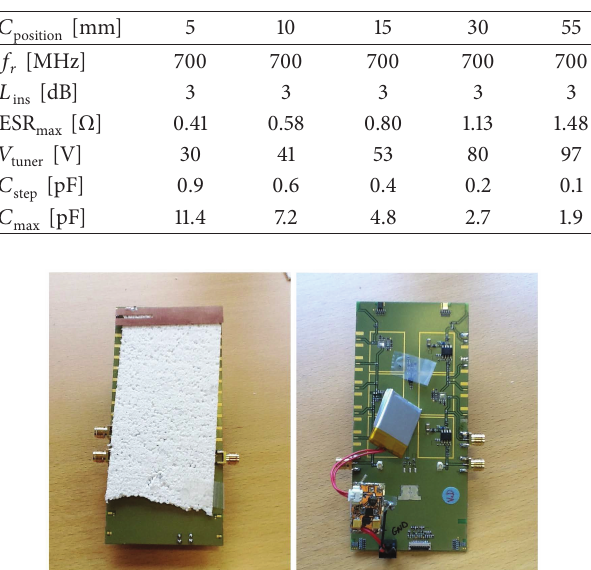
Table 1: Trade-offs due to location of the tuner.